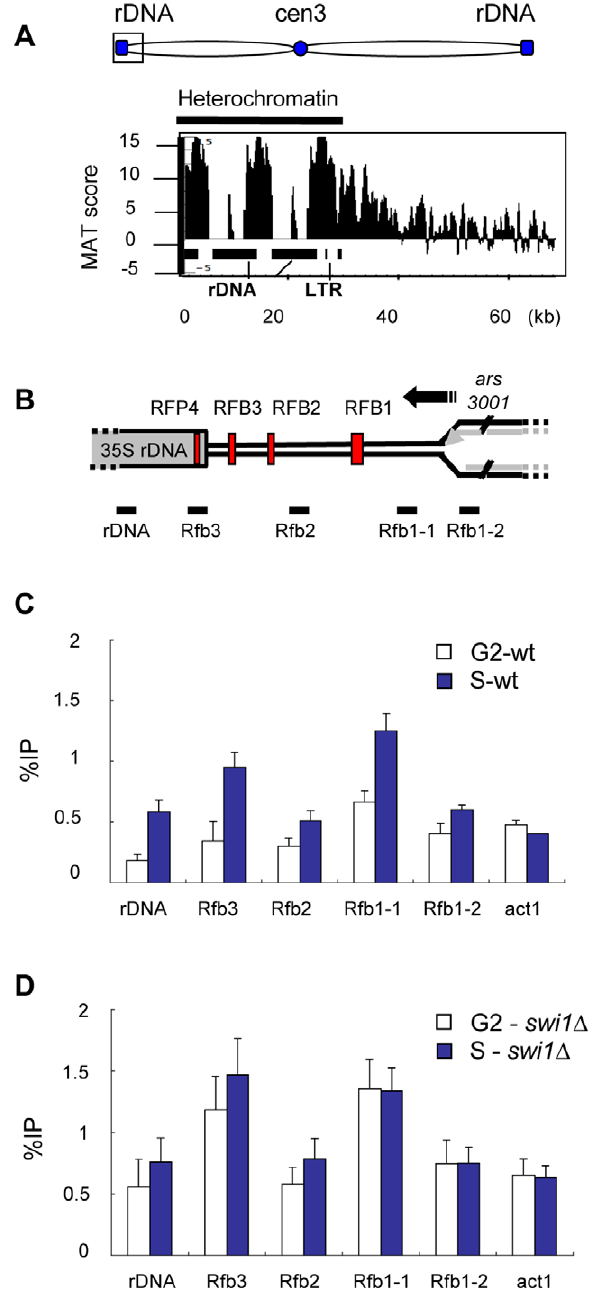
Figure 5. c H2A is highly enriched in the rDNA repeats during S phase. (A) Detailed ChIP-on-chip distribution of c H2A in the rDNA on the left arm of chromosome 3. Black rectangles (below graph) represent 35S rDNA gene repeats. (B) Diagram of one rDNA repeat (not to scale) shows the location of the four replication fork barriers (red vertical bars) relative to the 35S rDNA genes, the direction of replication (black arrow) from the ars3001 replication origin, and qPCR primer locations, below graph. (C, D) c H2A ChIP at the rDNA was performed in wild type and swi1 D strains synchronized by cdc25-22 block and analyzed by qPCR with the indicated primers.